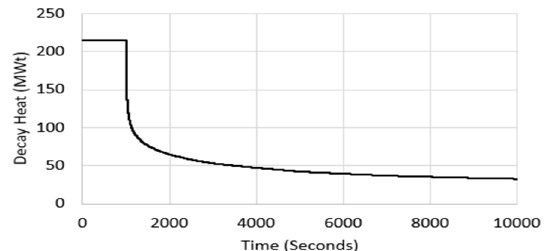
Fig. 4: Decay heat profile obtained after LBLOCA, SBO, TLFW and no SI